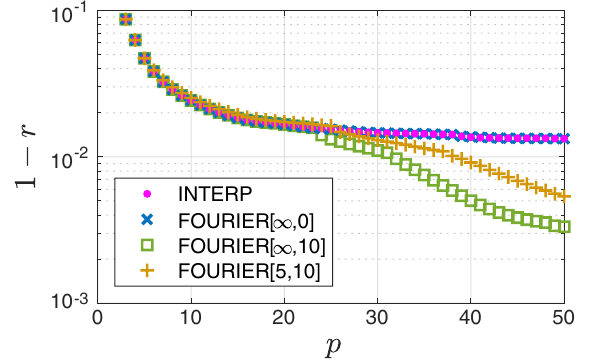
FIG. 11. The fractional error achieved by optimizing using our various heuristics on an example instance of a 14-vertex w3R graph. This instance is the same shown in Fig. 6(b).